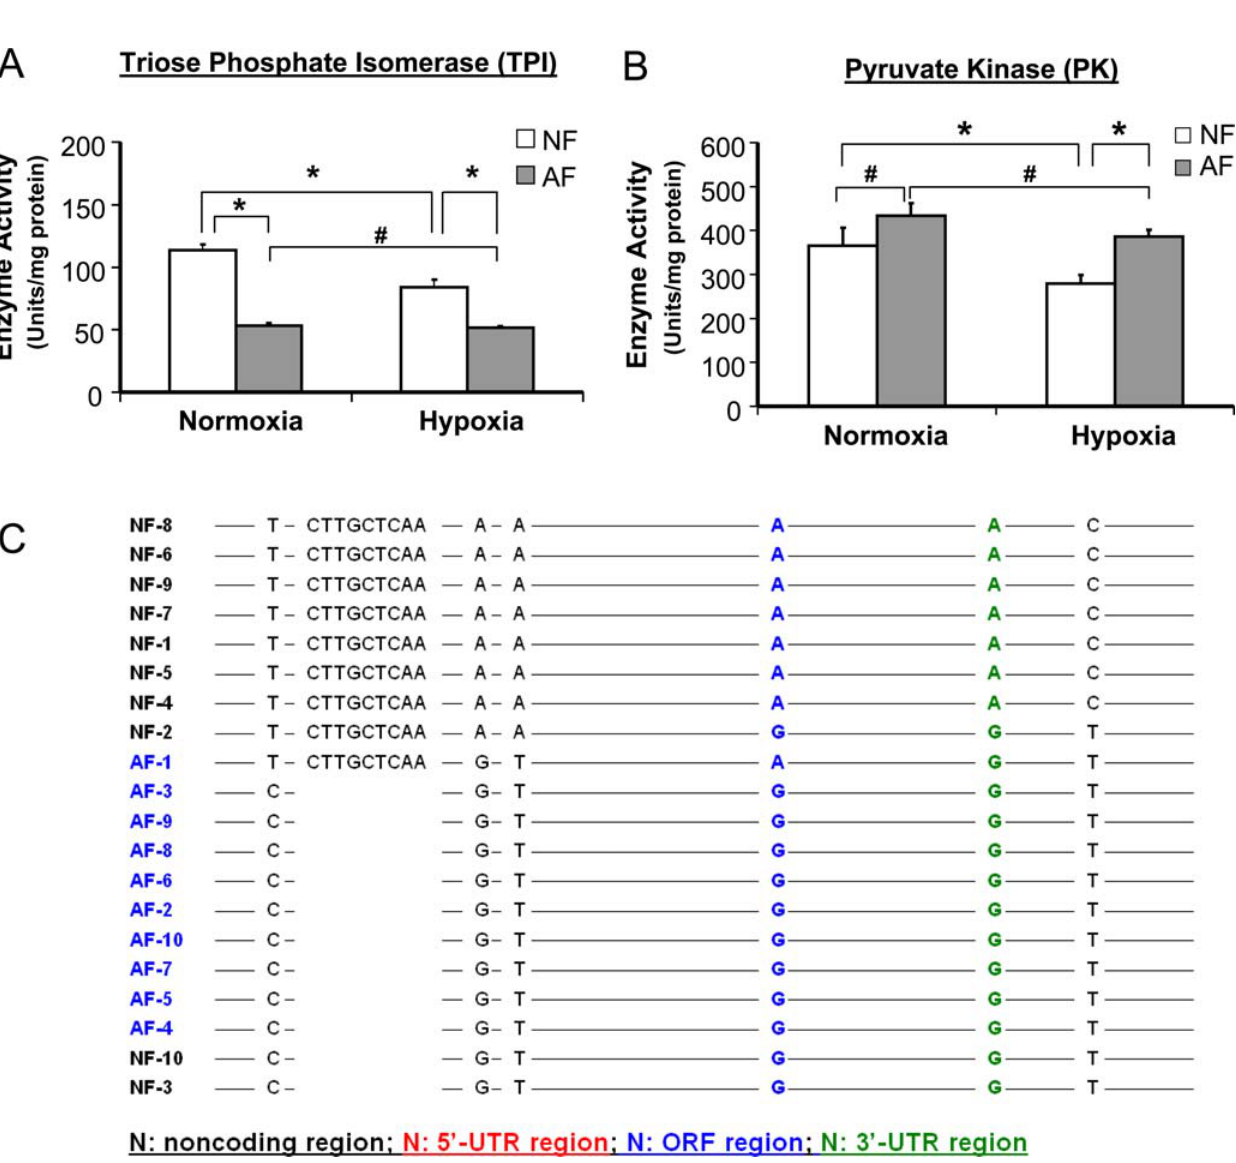
isopropanol. The DNA pellet was washed with 70% of ethanol and dissolved in TE buffer. The genomic locus encoding TPI gene was amplified by PCR using specific primers (forward primer: GTTTAAGGTCCGCA- GAGGTG, and reverse primer: ATTTTGGCAAGCCTGTT- GAT). All the coding exons and intronic flanking regions were amplified by polymerase chain reaction (PCR) using the high